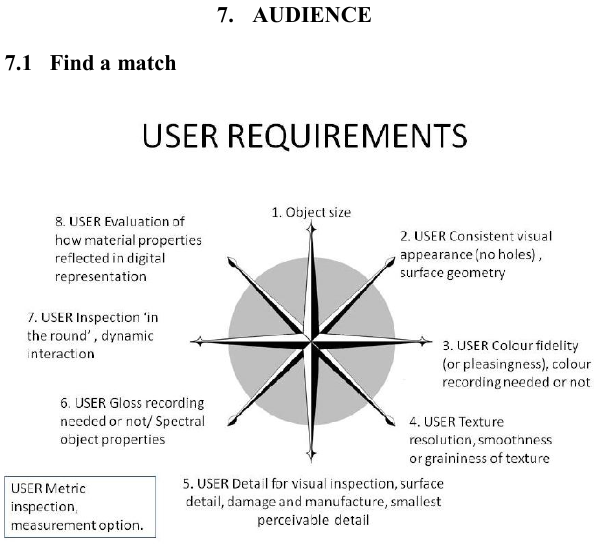
Figure 19.User requirements for 3D imaging.